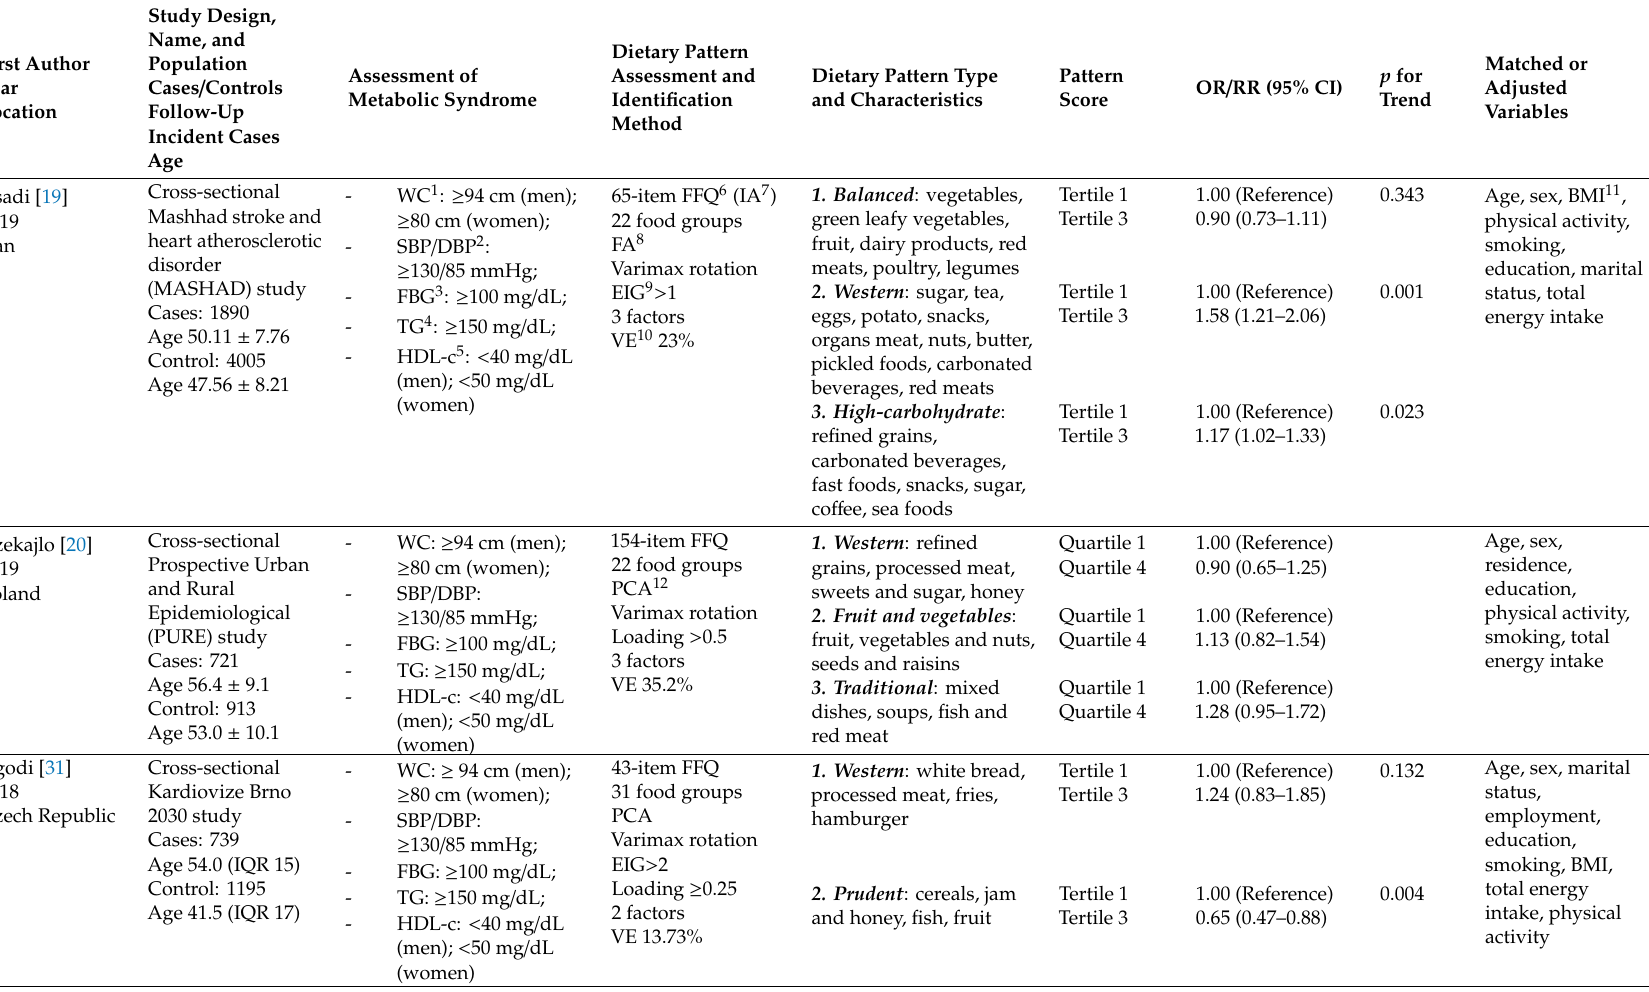
Table 1. Main characteristics of studies included in the systematic review and meta-analysis on dietary patterns and Metabolic